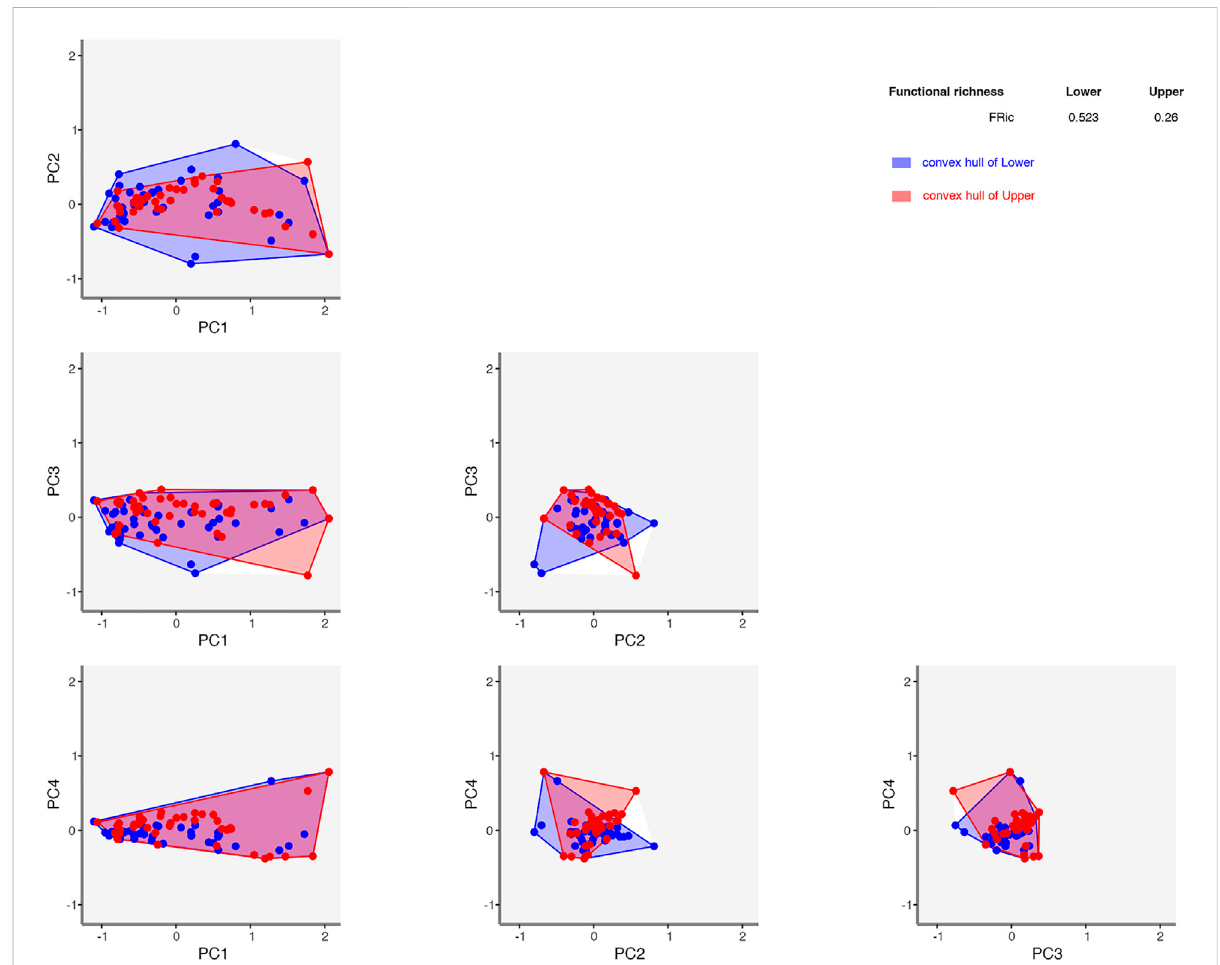
FIGURE 8 Functional richness (FRic) of upper (0.215) and lower basin (0.495) fi sh communities showing convex hulls and trait space per basin over 5 dimensions of space (accounting for 91% of observed variance in the data). Figure produced in